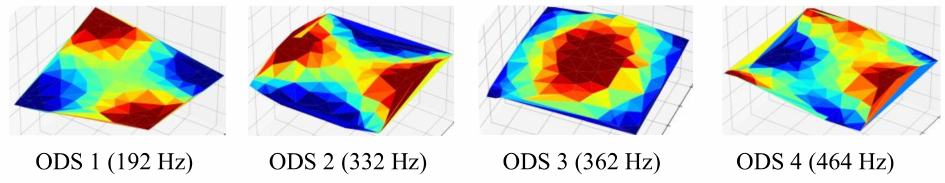
Figure 16. Operating deflection shapes at natural frequencies: healthy fully-assembled TPS